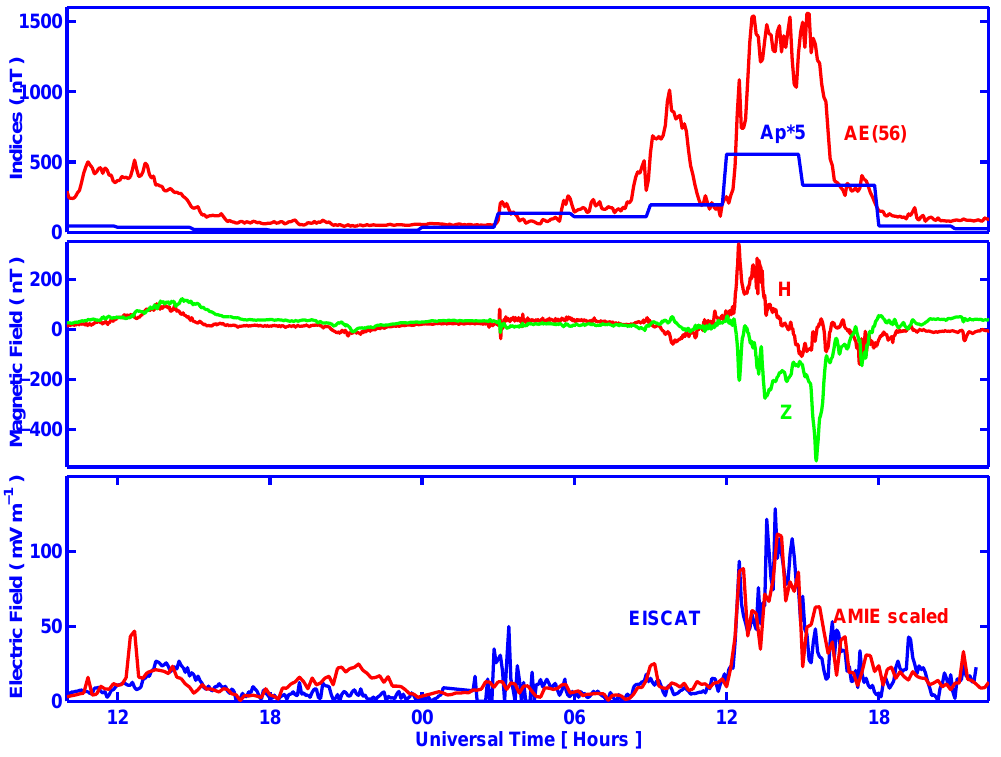
Fig. 4. From 16 February 1993 at 10:00 UT, to 17 February 1993 at 21:00 UT: Top panel: temporal evolution of geophysical indices Ap and AE(56). Middle panel: horizontal (H) and vertical (Z) component of the Tromsø magnetometer. Bottom panel: modulus of the electric field inferred from EISCAT-UHF tristatic measurements, and the corresponding scaled electric field resulting from AMIE computations (see